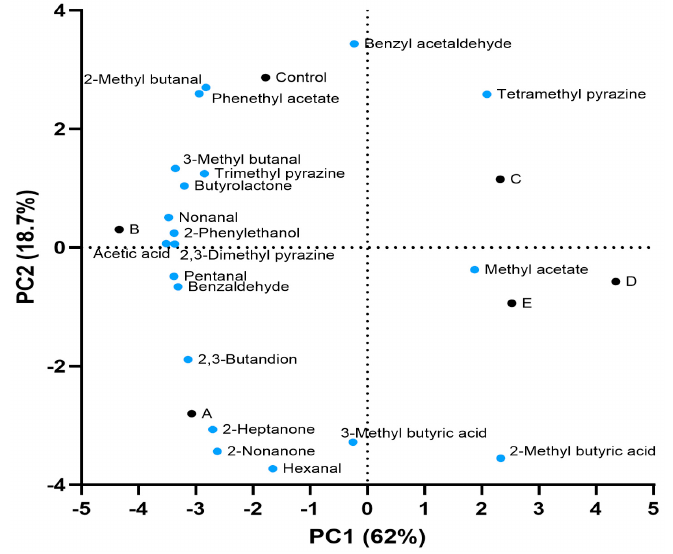
Figure 5. Volatile compounds analysis of cocoa liquor. Control: spontaneous fermentation; A: inoculated with L. fabifermentans at t 0 ; B: inoculated with L. fabifermentans at t 0 and t 48 ; C: inoculated with F. rossiae at t 0 ; D: inoculated with F. rossiae at t 0 and t 48 ; E: inoculated with both strains at t 0 and t 48 .